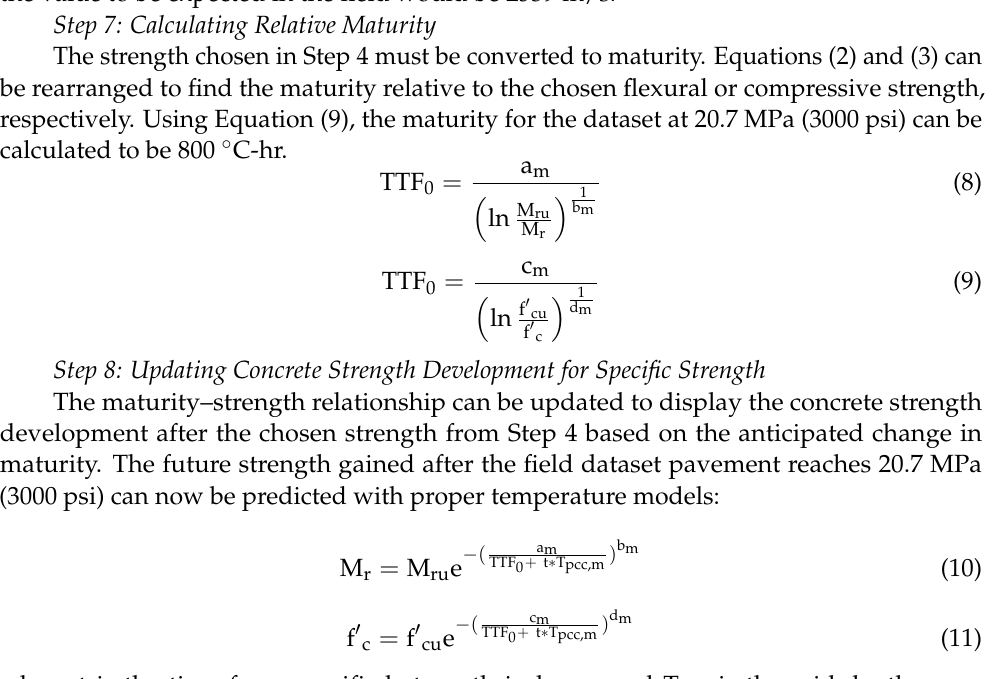
Figure 4. Adjusting the field wave velocity.